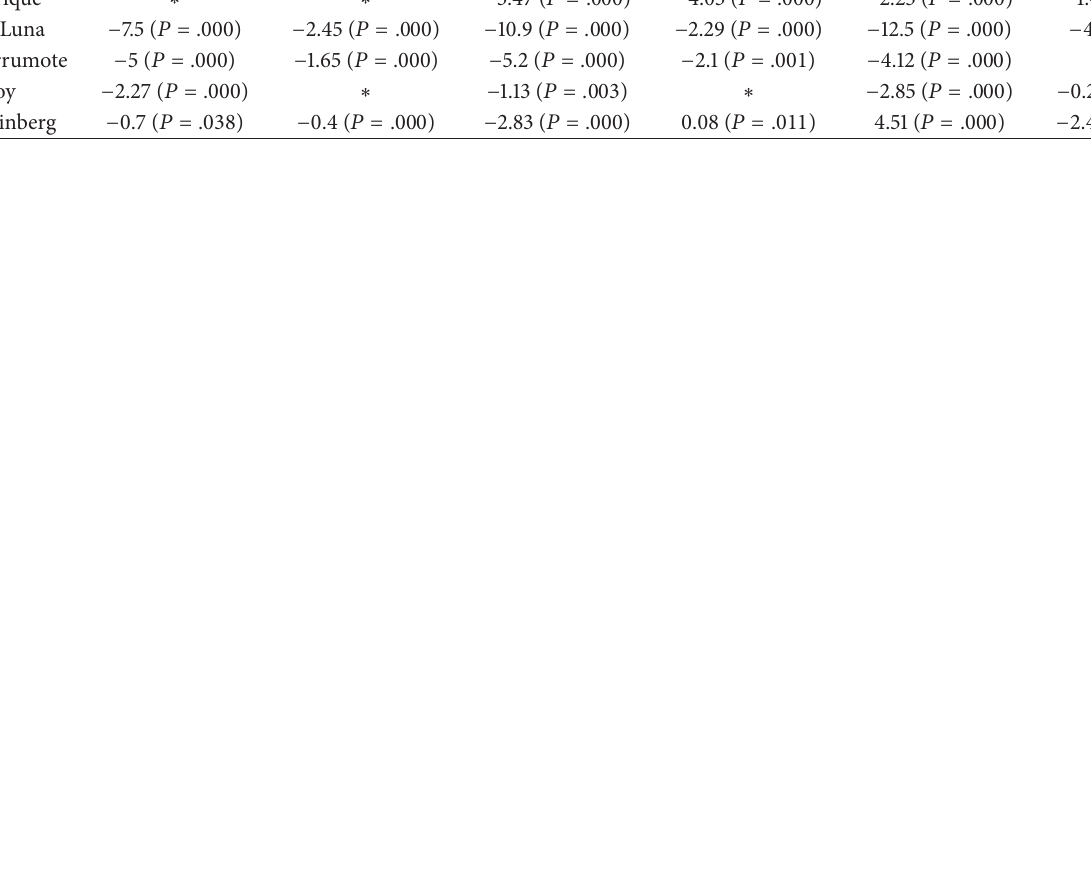
Table 4: Colony distribution departure from randomness; 𝑧 and 𝑃 values (in parenthesis) from the test of significance for the three 100 m 2 quadrants in the different sites. (—): no data was found. ( ∗ ): not significant data. Q 1 Q 2 Q 3 Reef Healthy + YBD YBD Healthy + YBD